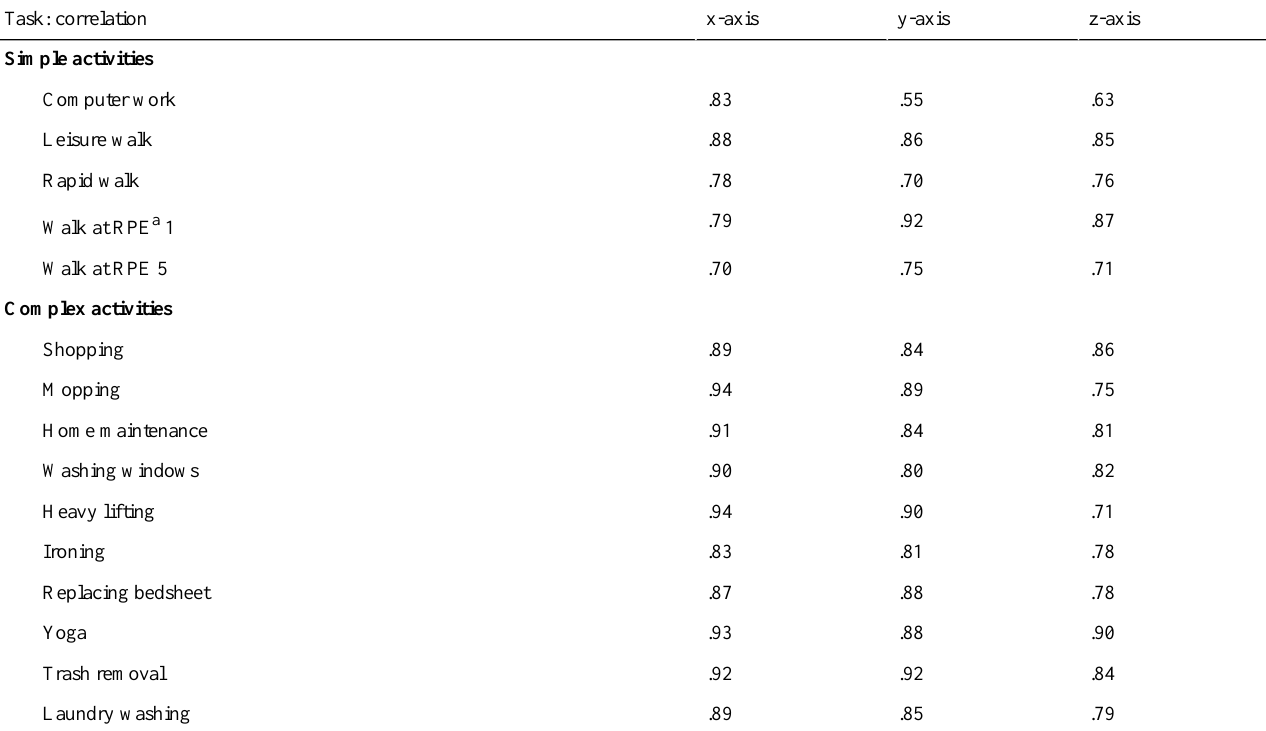
Table 4. Correlations of 1-second root mean square for all 3 axes of the Samsung Gear S smartwatch and ActiGraph GT3X+ by activity. All correlation values were statistically